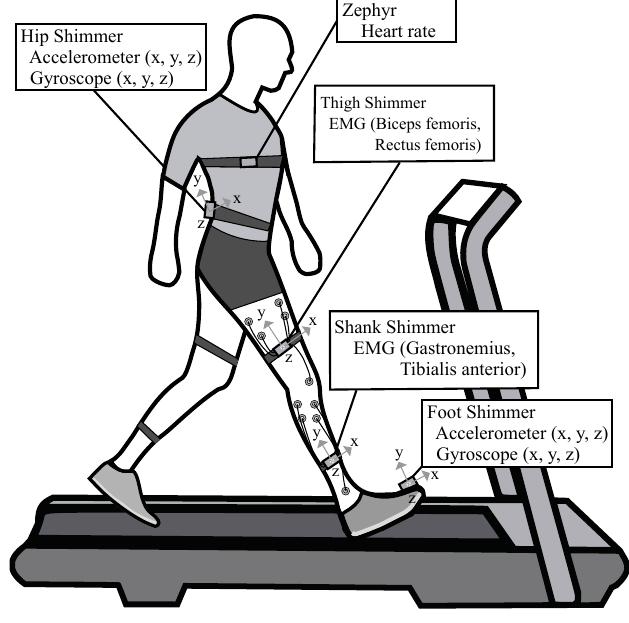
Figure 1. Experimental setup. Each participant was instrumented on their dominant side with an IMU placed on the dorsal side of their foot and with an IMU placed on their spine between L2 and S1. two more IMUS located on each thigh and shank with different electrodes situated in tibialis anterior, rectus femoris, biceps femoris, and gastrocnemius. Participant’s heart rate was captured using the Zephyr sensor located on their